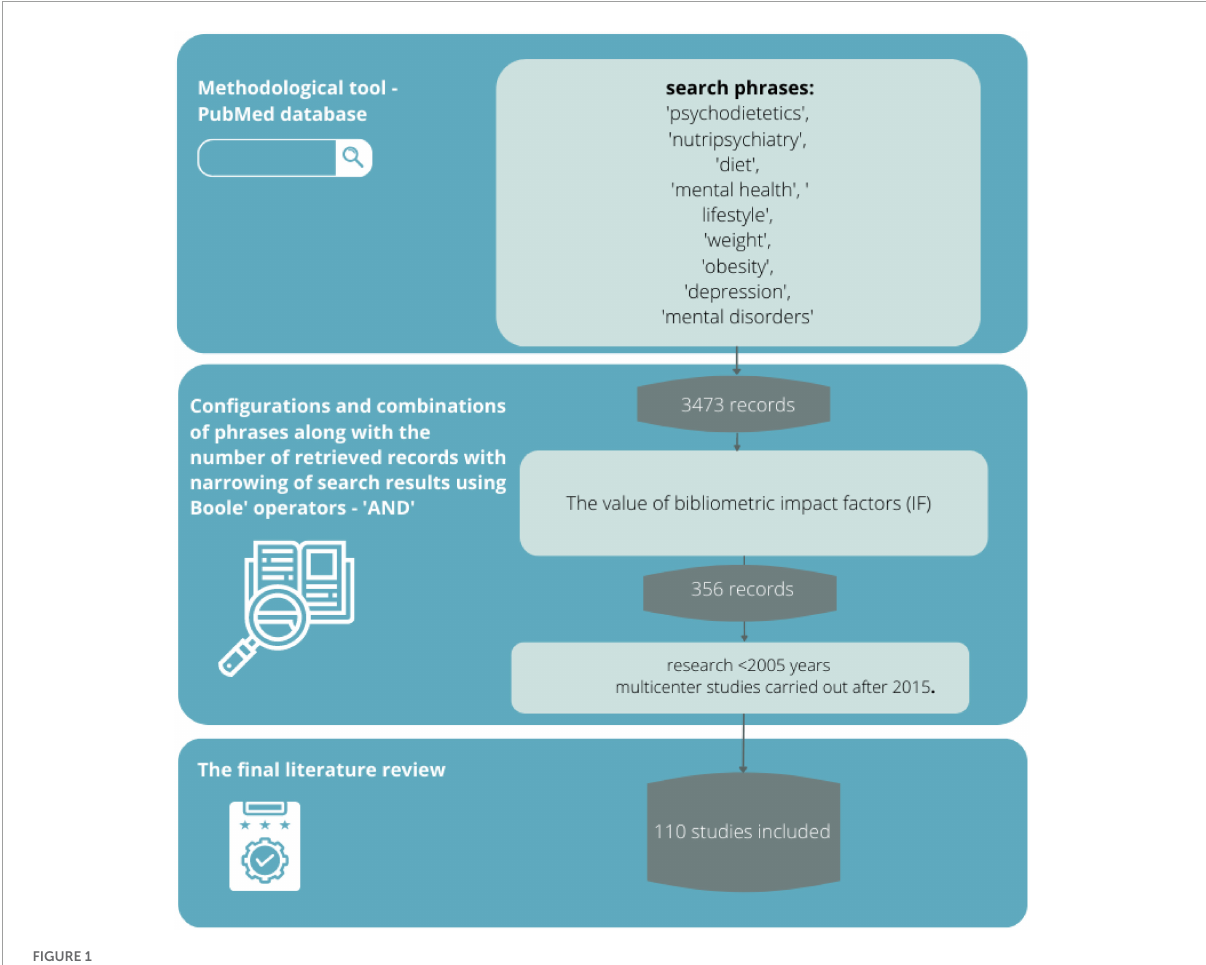
FIGURE1 A flowchart of how to proceed in selecting bibliographic